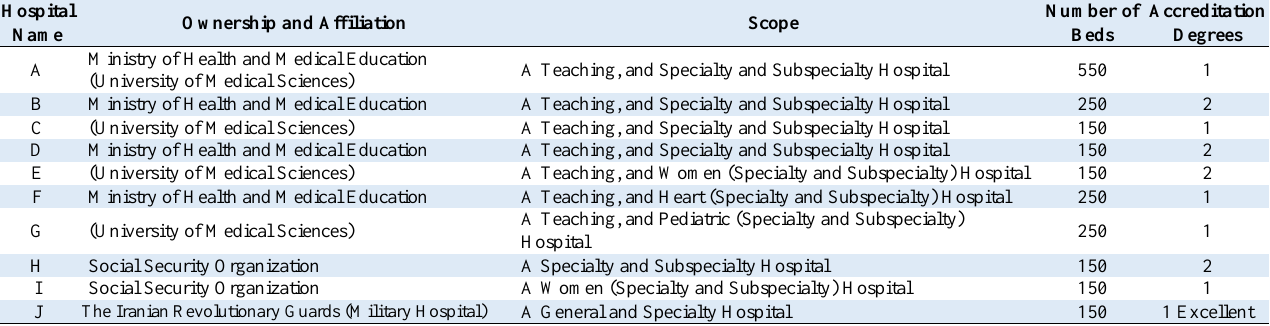
Table 1. The characteristics of the studied hospitals